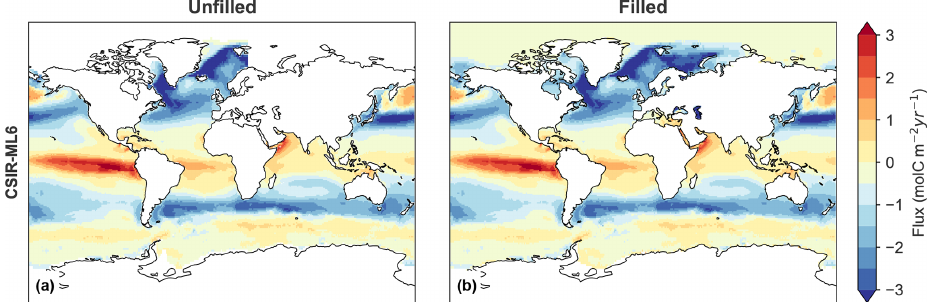
Figure 3. Mean flux (molm − 2 yr − 1 ) for 1990–2019 for CSIR-ML6 product. (a) Map of mean-calculated flux using the original p CO 2 product and three scaled wind products (CCMPv2, ERA5, JRA55); (b) map of mean-calculated flux using the filled p CO 2 product and three scaled wind products. Similar maps for all other products are available in Fig.